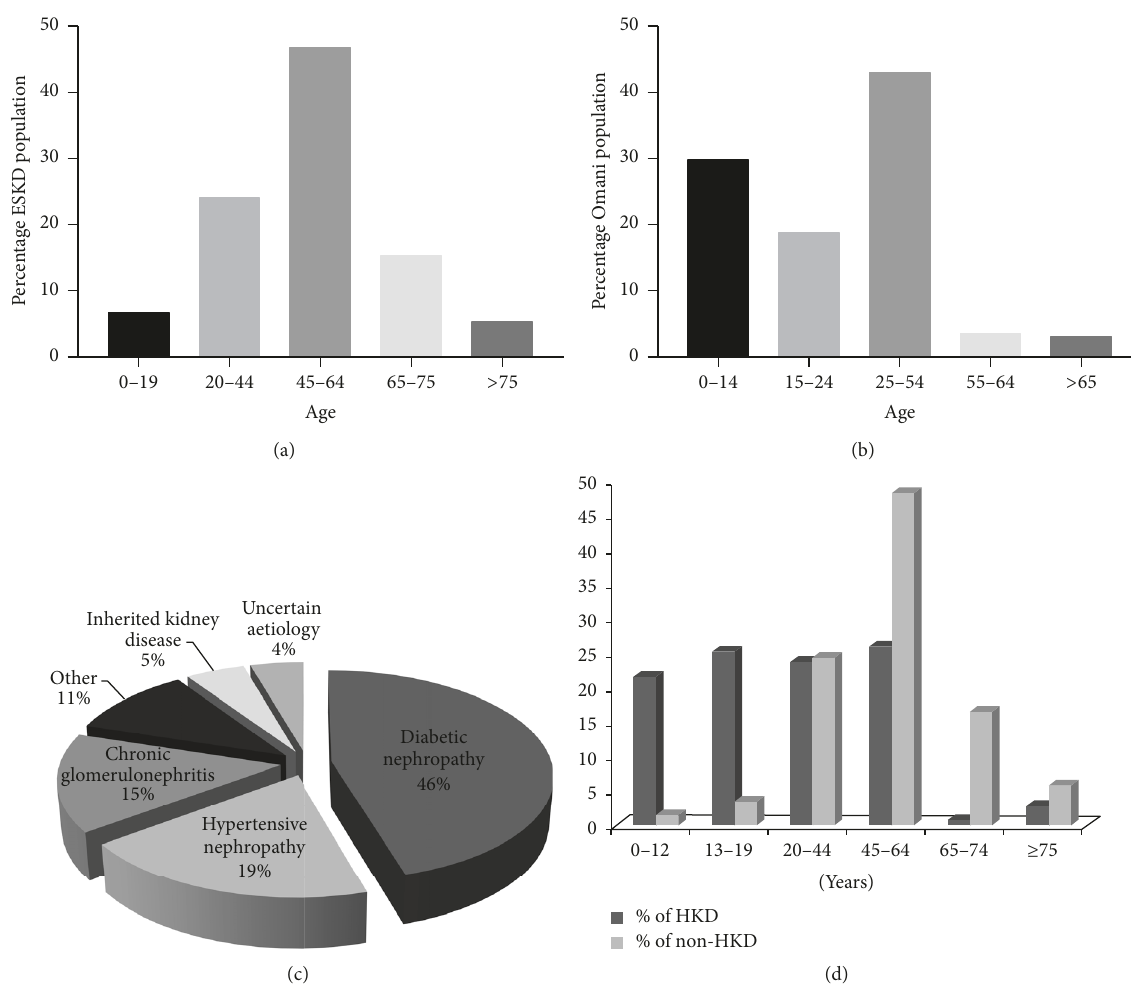
Figure 1: Characteristics of ESKD patients commencing RRT in Oman . (a) Percentage age distribution of patients with ESKD. (b) Percentage age distribution of Omani population (2014 data). (c) Aetiology of ESKD in Oman. (d) Comparison of percentage of patients with hereditary kidney disease (HKD) and nonhereditary kidney disease (non-HKD) across age groups.